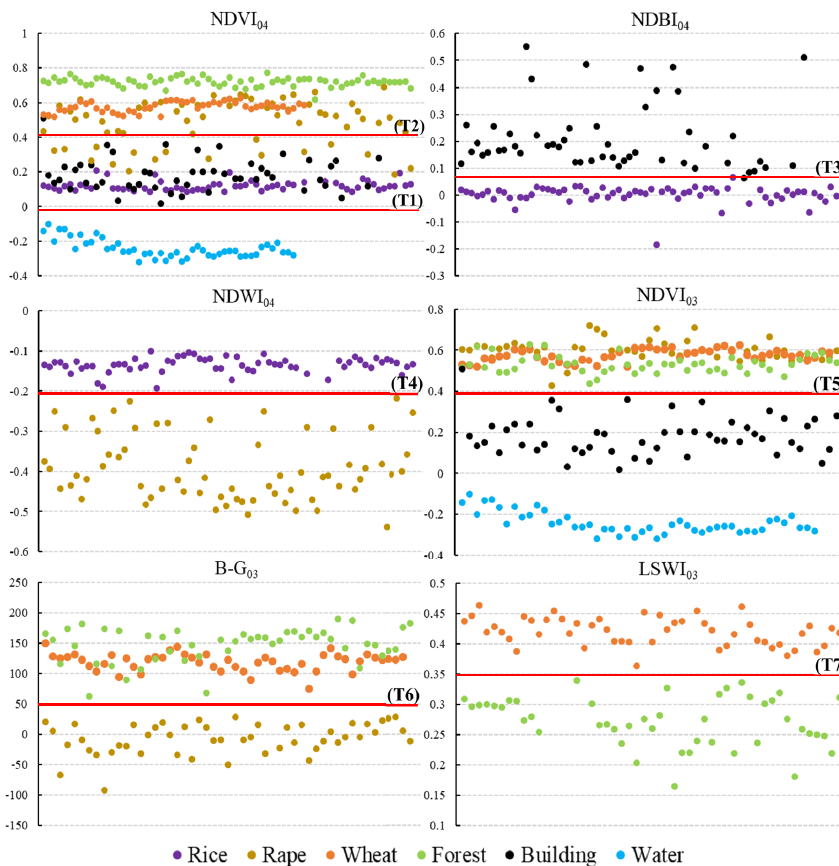
Figure 8. Comparison between the temporal profiles of the normalized di ff erence vegetation (NDVI), normalized di ff erence water index (NDWI), land surface water index (LSWI) and blue-green ratio (B-G) for the di ff erent land cover types on the middle-lower Yangtze River plain. Red lines represent the classification threshold. Agriculture 2020 , 10 , x FOR PEER REVIEW 10 of 17